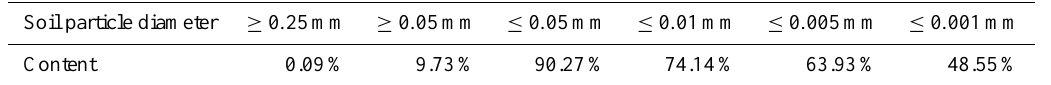
Table 1. Soil particle composition. Soil particle diameter